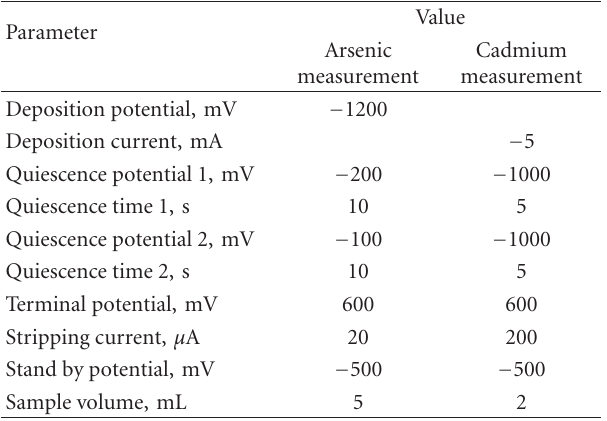
Table 1: Operation parameters of the electrochemical